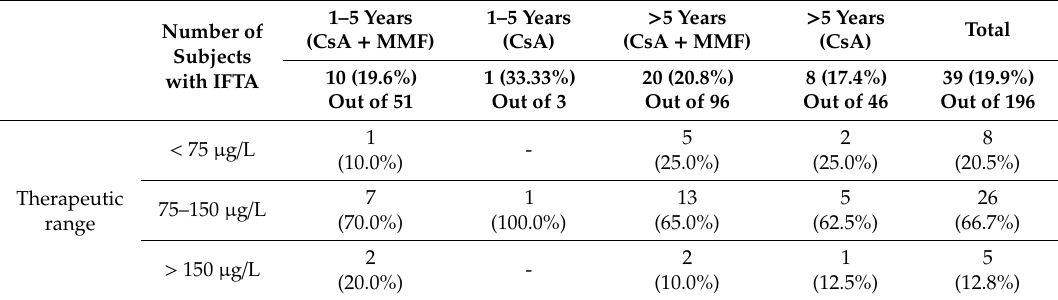
Table 11. CsA C 0 compliances within the therapeutic range in patients with IFTA (1–5 years and > 5 years post-transplantation